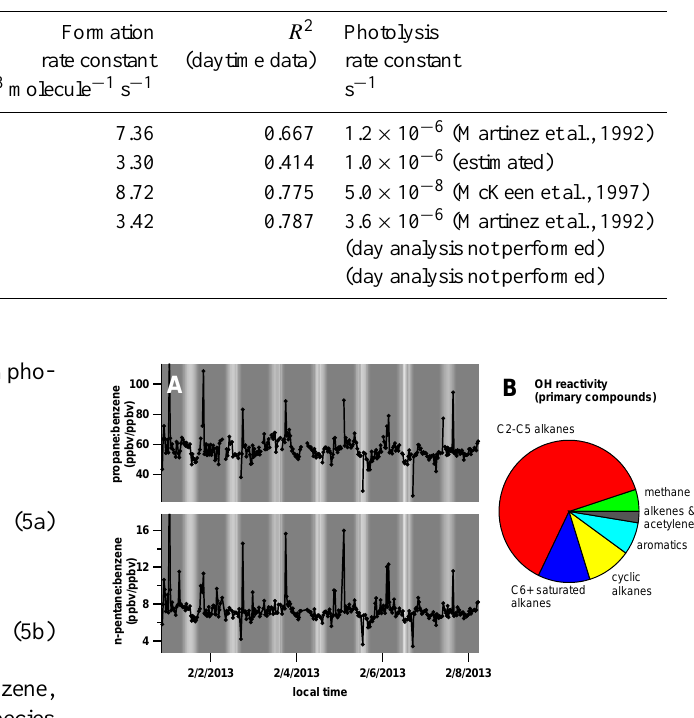
Figure 8. (a) Because of their slow reaction rates with OH, the ra- tios of C2–C5 alkanes to benzene did not have high diurnal vari- ability and did not change substantially from beginning to end of the stagnation event (propane and n -pentane measured by GC-FID are shown as representatives). (b) However, because of their high mixing ratios, these species account for a large fraction ( ∼ 70%) of primary hydrocarbon–OH